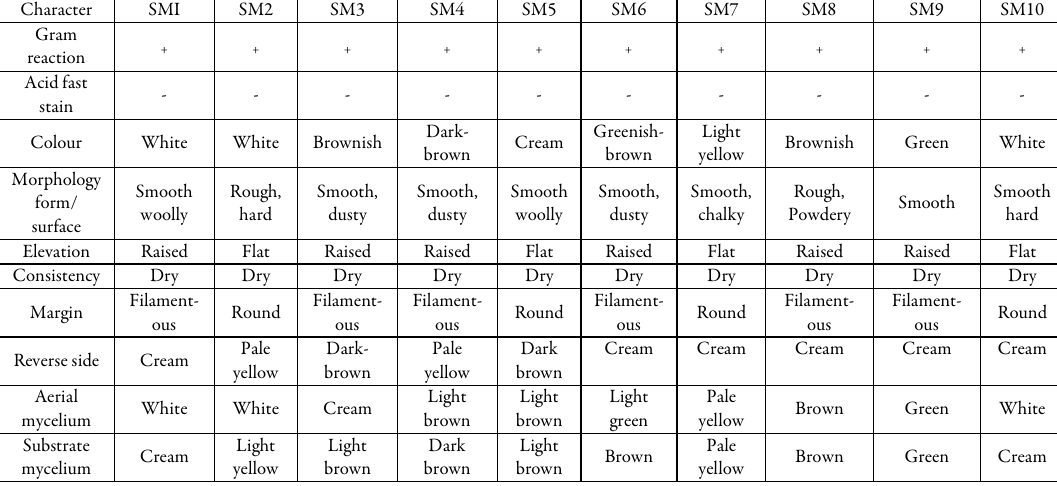
Figure 1 . Sensitivity pattern of test bacteria to Actinomycetes isolated from Ilorin metropolis soils Table 3. Morphological and cellular identification of Actinomycetes